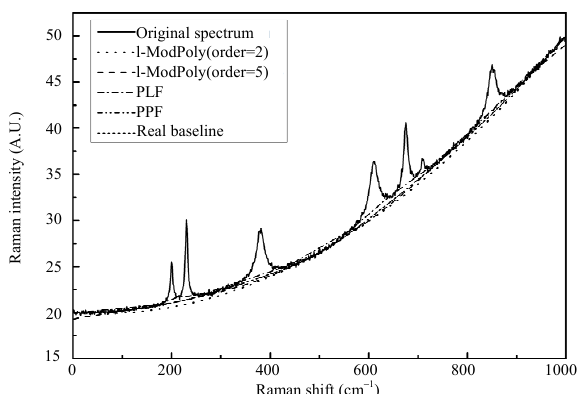
Fig. 7 Baseline correction for simulated Raman spectra with